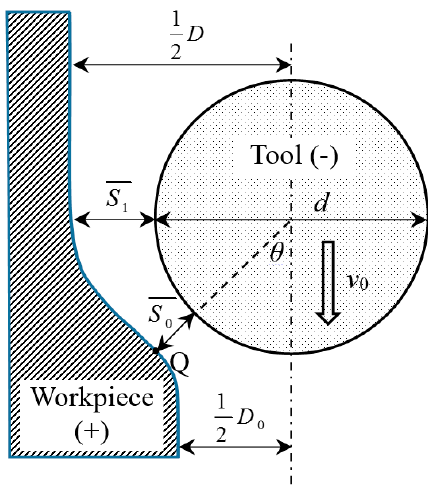
Figure 7. Schematic diagram of UAECDG.